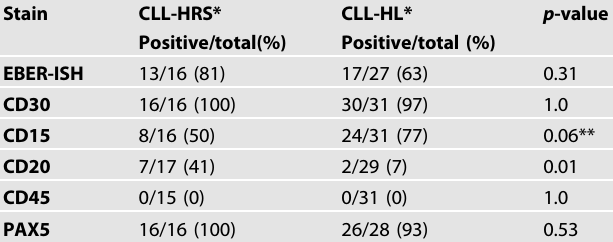
CLL-HRS Chronic lymphocytic leukemia/small lymphocytic lymphoma with Hodgkin/Reed – Sternberg-like cells, CLL-HL Classic Hodgkin lymphoma, EBER Epstein Barr Virus encoded RNA, ISH in situ hybridization. *Cases with both CLL-HRS and CLL-HL areas are included in both totals. **Most p -values based on Fisher ’ s exact test; one based on Chi-square